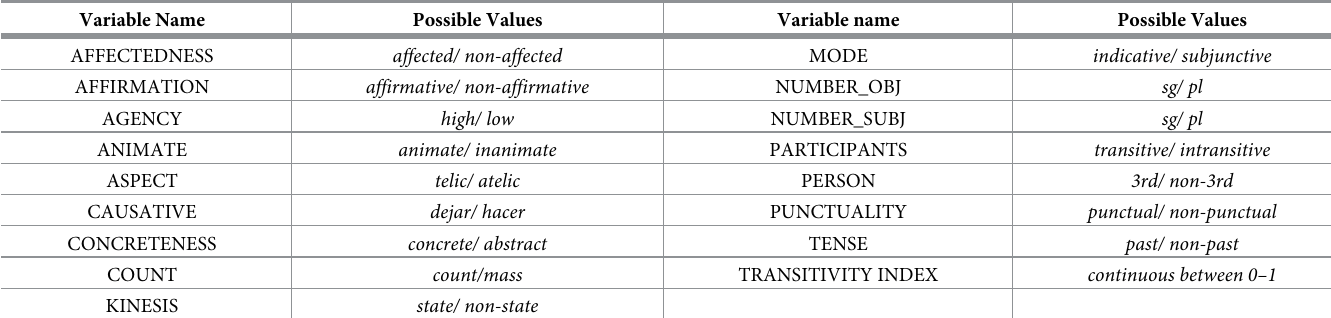
Table 4. Predictor variables and possible values of